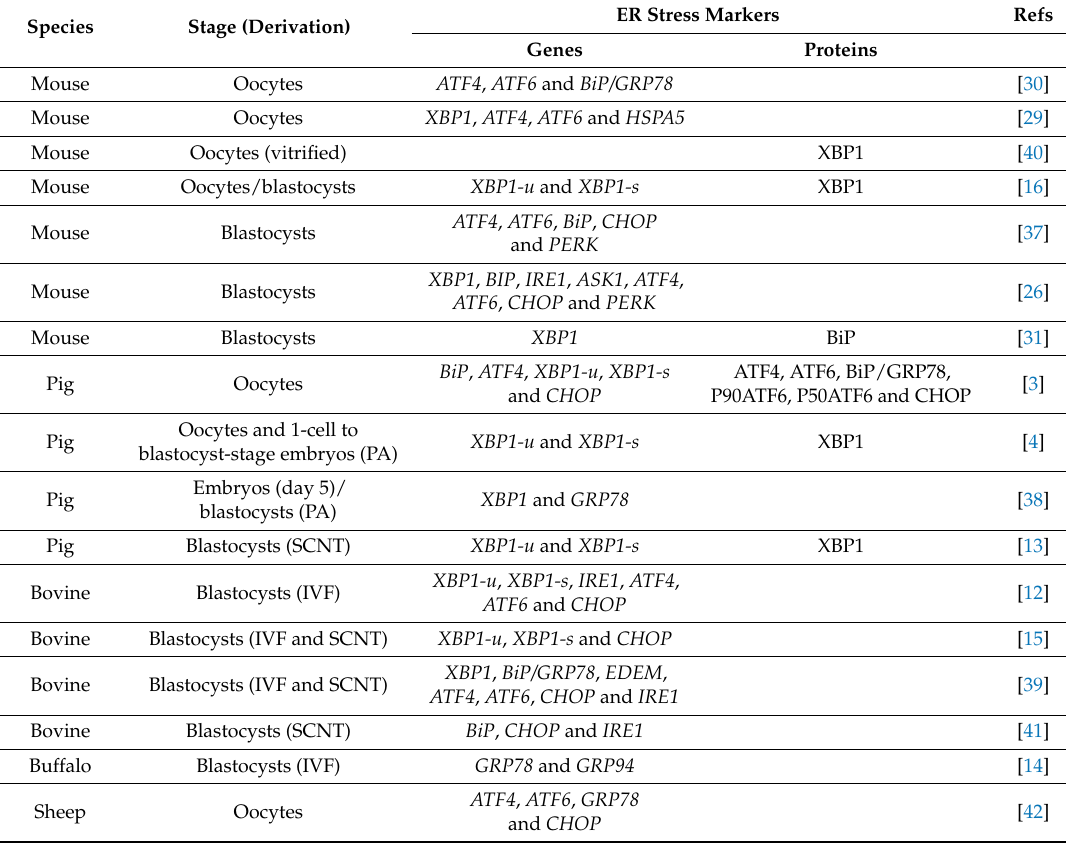
Table 1. Intrinsic endoplasmic reticulum stress markers identified in mammalian oocytes and preimplantation